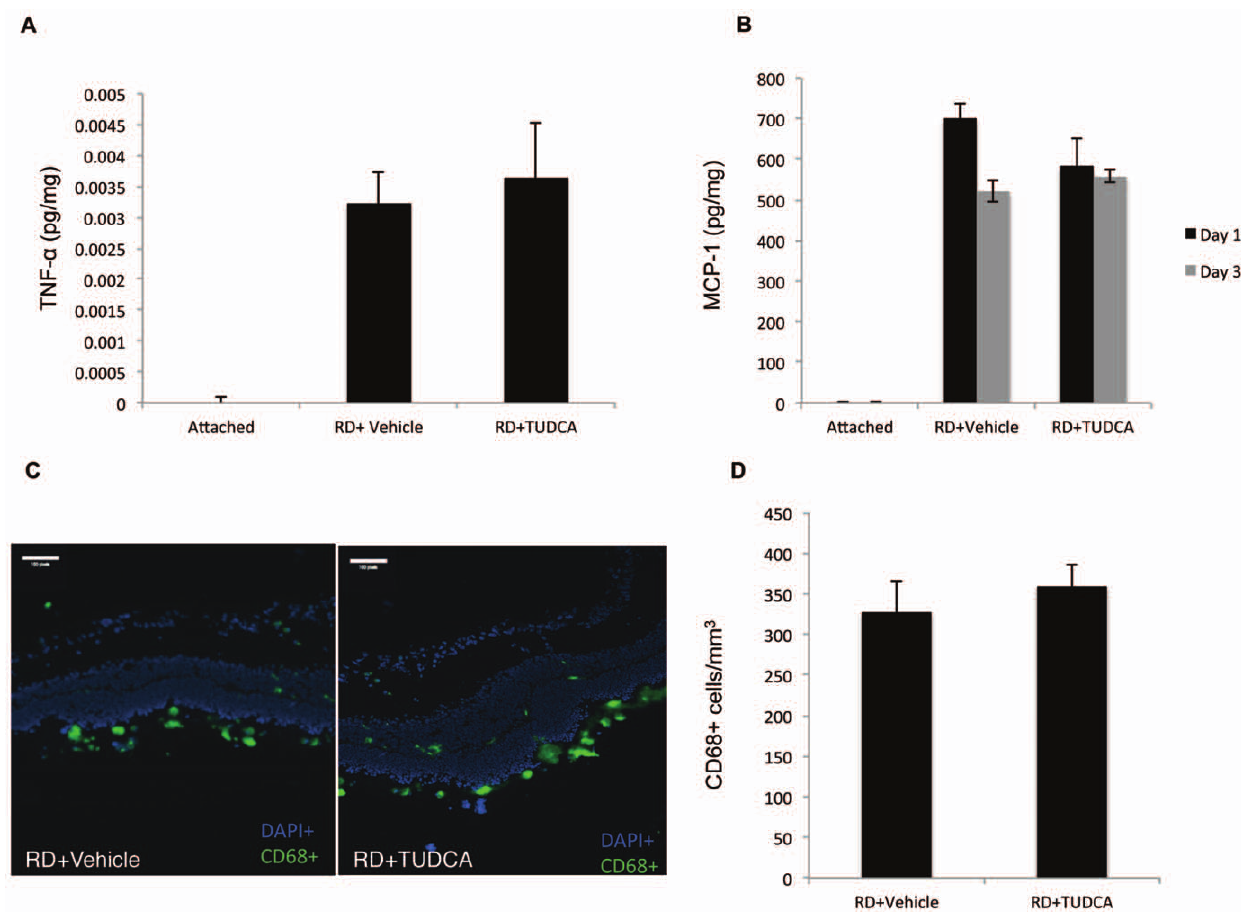
Figure 2. TUDCA did not diminish the inflammatory response after RD. ELISA for TNF- a ( A ) and MCP-1 ( B ) levels 1 day after RD. TUDCA was administered as in Figure 1. Immunostaining ( C ) and quantification ( D ) for infiltrating CD68 + cells (green) 1 day after RD. Nuclei were counterstained with DAPI (blue) TUDCA was administered as in Figure 1 (A) (n=6, P . 0.05).